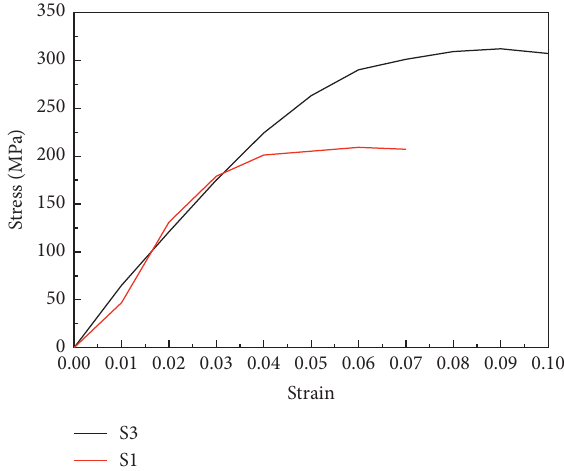
Figure 9: Stress-strain curves at different temperatures for the same reduction rate.